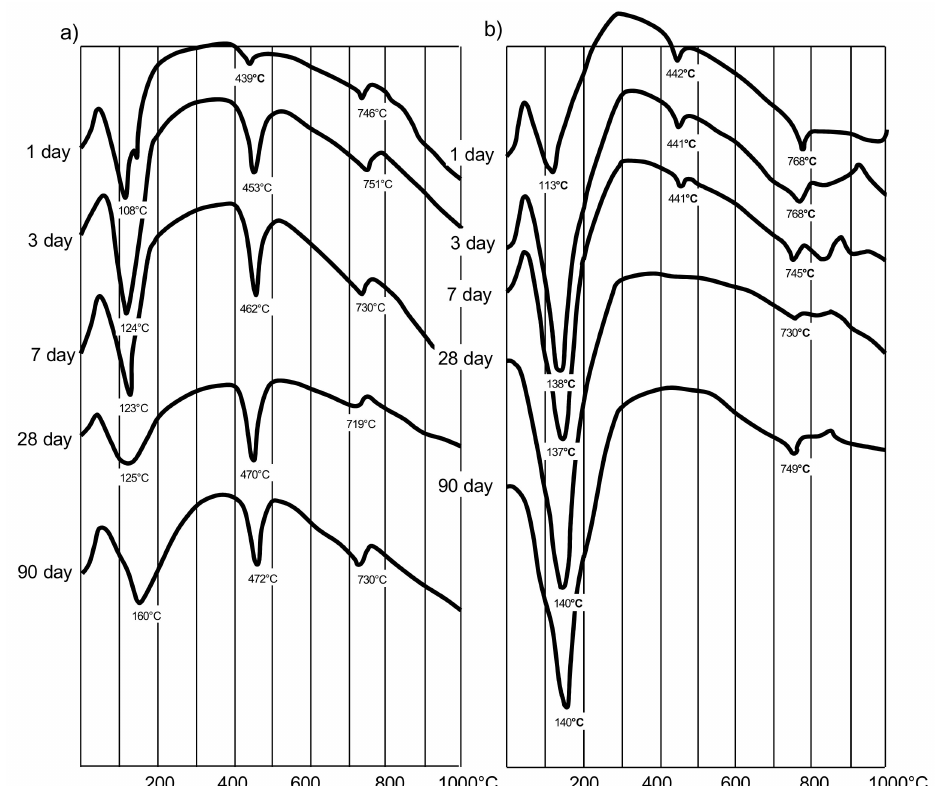
Figure 3. DTA curves: ( a )—cement stone containing 40% fly ash ( a ) by weight of cement; ( b )—cement stone containing 40% AMAd (30% MK is part of AMAd).